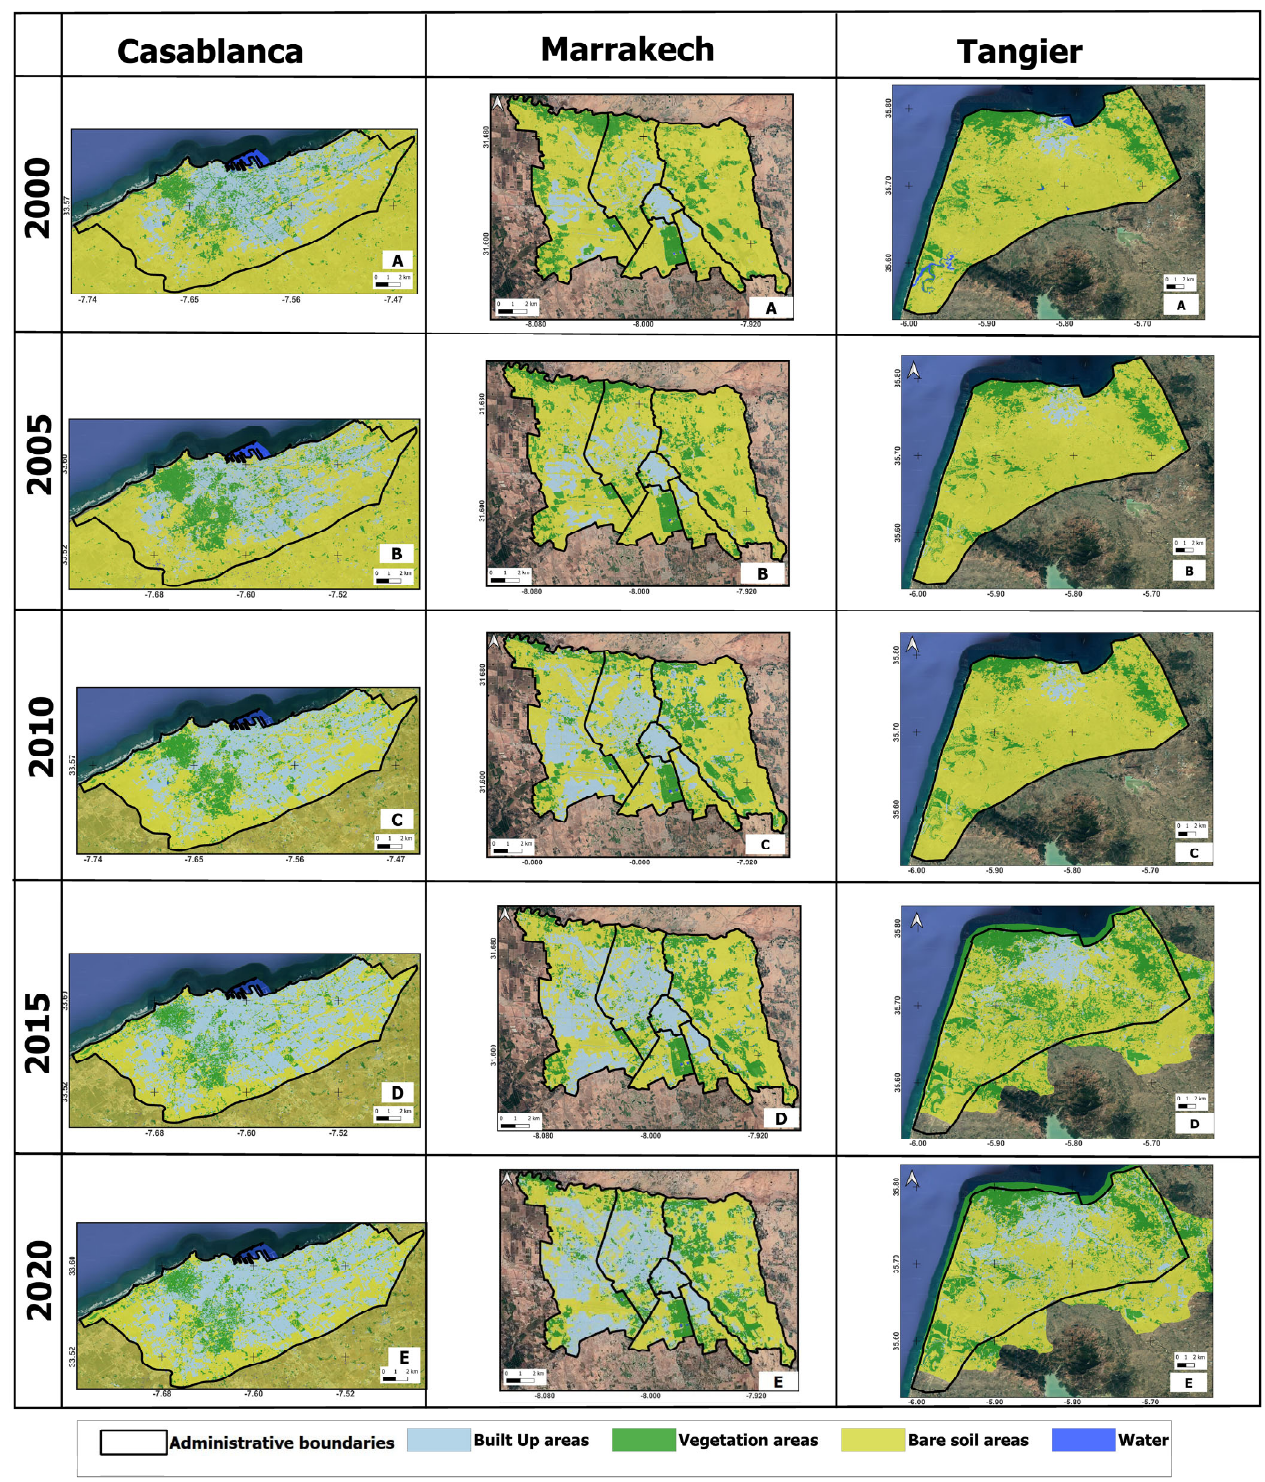
Figure 3. Thematic maps for 3 targeted cities: ( A ) 2000, ( B ) 2005, ( C ) 2010, ( D ) 2015, and ( E ) 2020.